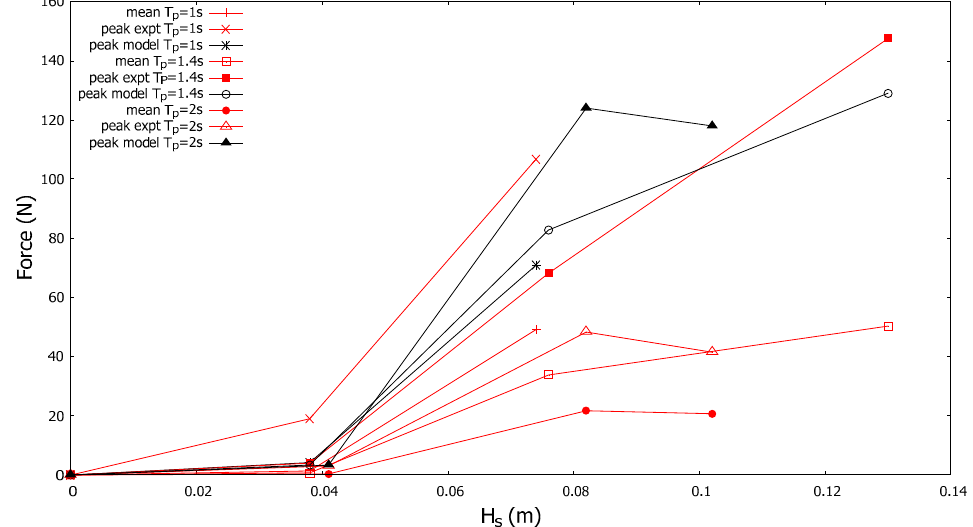
Figure 13. Variation of horizontal fairlead mooring force with H s for T p = 1, 1.4, 2 s from experiment and linear diffraction/radiation model with measured mean force.